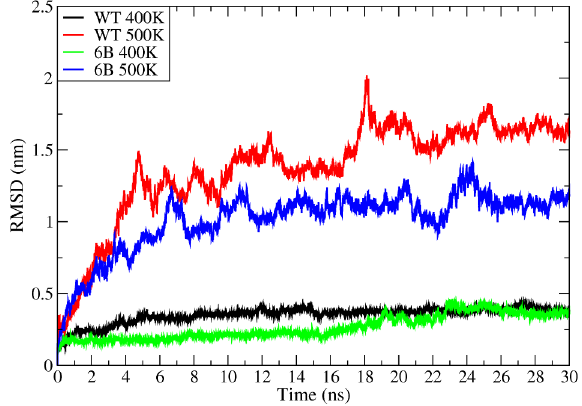
Figure 13. RMSD of C a atoms. Root Mean Square Deviations of C a atoms for WT and 6B at 400 K (Black and Green respectively) and 500 K (Red and Blue respectively). doi:10.1371/journal.pone.0102856.g013 PLOS ONE |